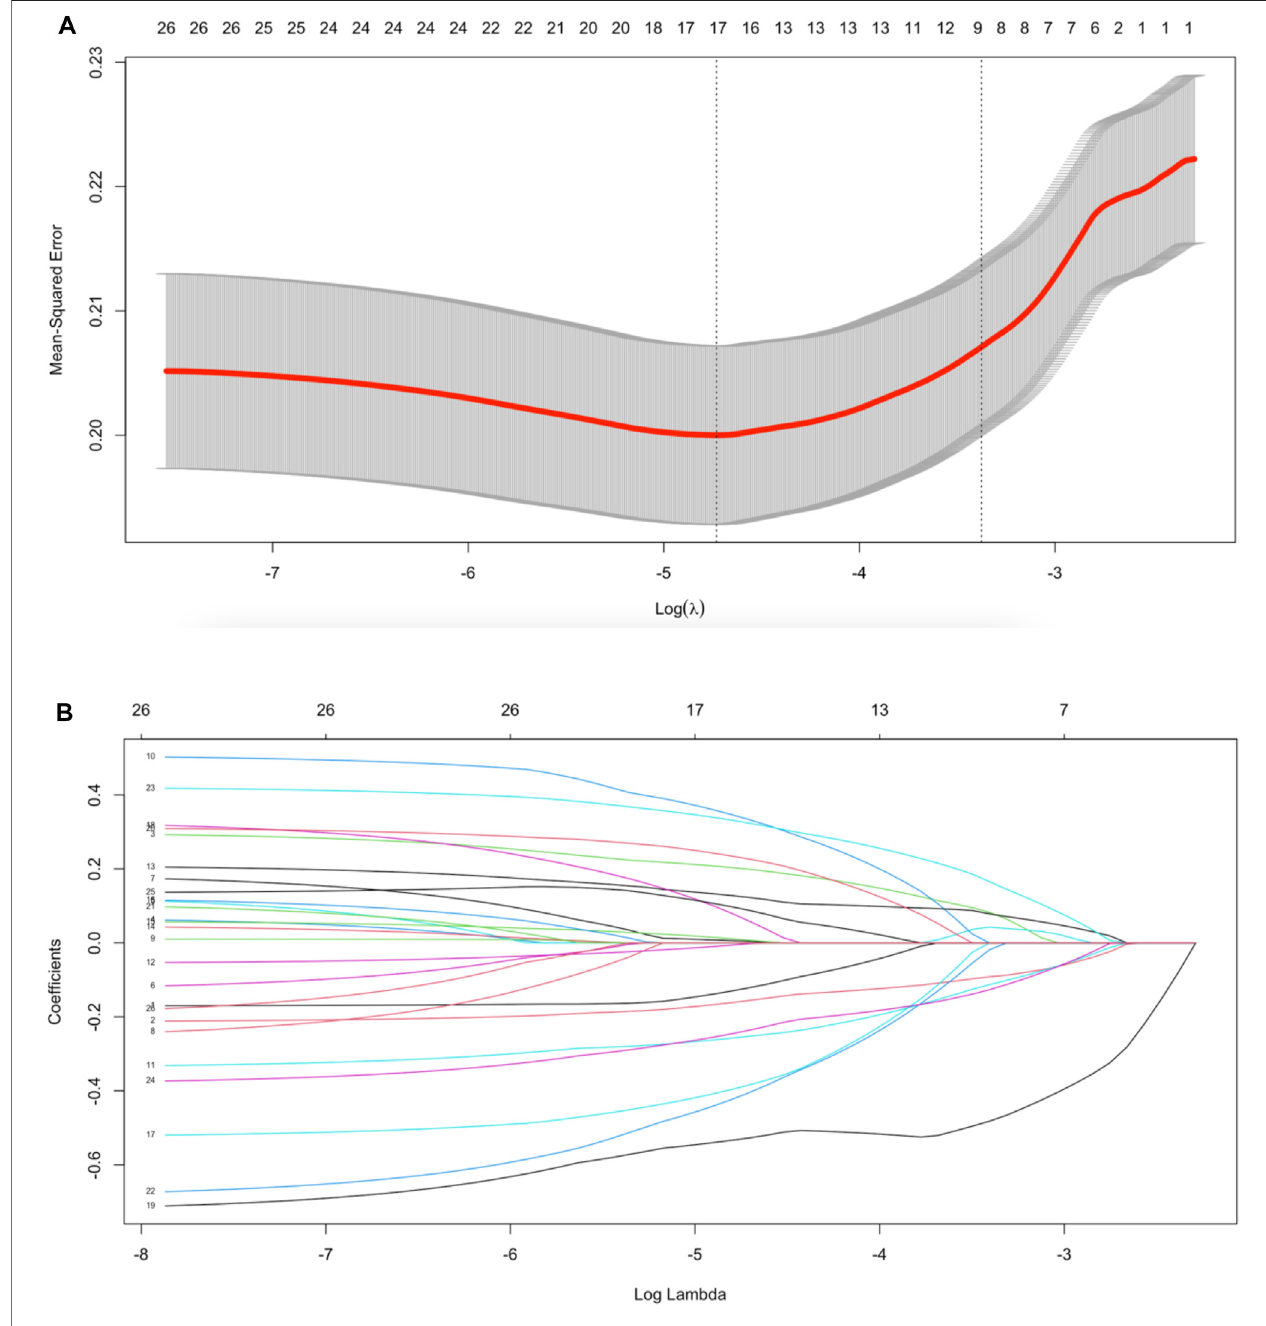
FIGURE6| Construction and veri fi cation ofthe necroptosis-relatedmolecules riskprediction model. (A) 1000-time cross-validationfortuningparameter selection in the LASSO model; TCGA cohort. (B) LASSO coef fi cient pro fi les of 26 necroptosis-related genes; TCGA cohort. (C) Risk score range in two groups (0 equals alive, 1 equalsdeath);TCGAcohort. (D) Datasetsassignedtohigh-riskandlow-riskgroupsbasedontheriskscore.Kaplan – MeiercurvefortheHNSCC-TCGAcohort,highrisk (192cases),lowrisk(192cases)UnitofTime(years). (E) Receiveroperatingcharacteristic(ROC)curve(AUC=0.74);TCGAcohort. (F) TIME-ROCcurveinHNSCC- TCGAcohort. (G) Plotinmultivariate Coxregressionandsomeparameters oftheninenecroptosis-relatedgenessignatureinGSE65858 database (Concordanceindex = 0.61, log rank p = 0.00417). (H) HNSCC patients in high-risk and low-risk groups based on the risk score. Kaplan – Meier curve for the GSE65858 cohort, high risk (134cases),lowrisk(133cases),UnitofTime(years). (I) HNSCCpatientsinhigh-riskandlow-riskgroupsbasedontheexpressionofTRAF5.Kaplan – Meiercurveforthe TCGA cohort, high risk (235cases), low risk (149 cases), Unit of Time (years). (J) HNSCC patients in high-risk and low-risk groups based on the expression of ZBP1. Kaplan – Meier curve for the TCGA cohort, high risk (177cases), low risk (207 cases), Unit of Time (years). (K) HNSCC patients in high-risk and low-risk groups based on the expression ofSLC25A5.Kaplan – Meier curve fortheTCGA cohort,high risk(234cases),lowrisk(150cases),Unit ofTime(years). (L) SLC25A5expression innormal nasopharyngeal epithelial cell line (NP69) cell line and HNSCC cell line (CAL-27), quantitative real-time PCR assay, ** p < 0.01.